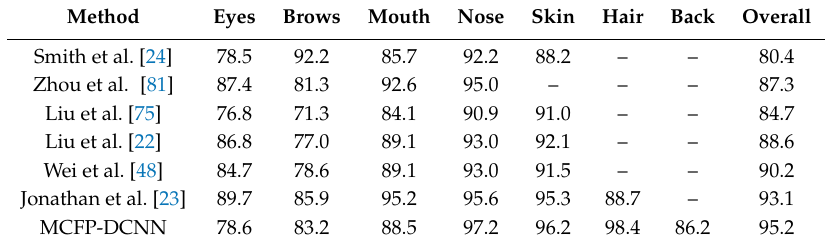
Table 4. Face parsing: comparison of the MCFP-DCNN with SOA on HELEN DB. The reported results are for F1 measure.